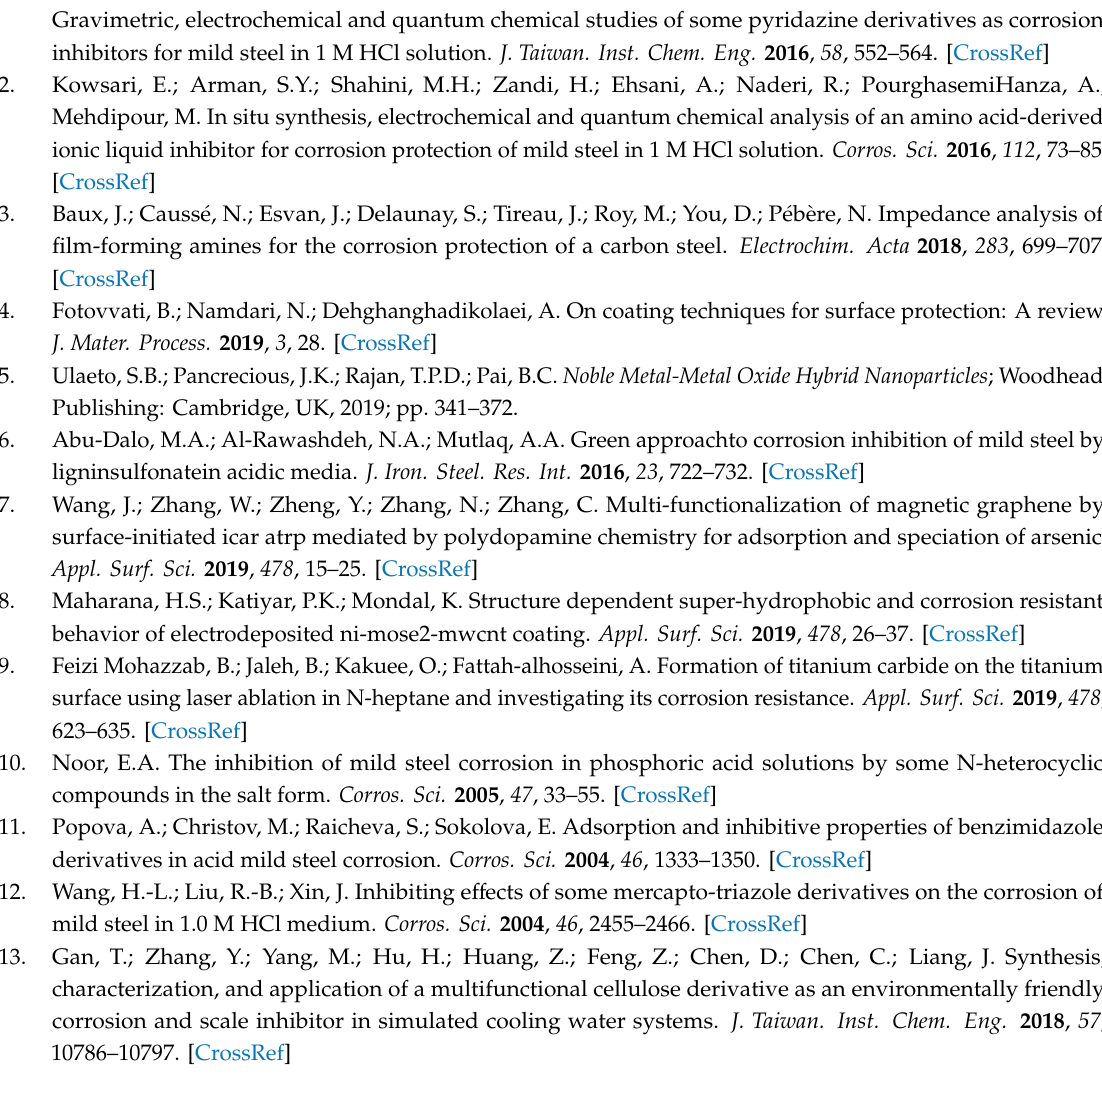
Figure S1. Schematic diagram of a lignin-DMC synthesis device, Figure S2. (a) The reaction mechanism and (b) The sketch of the lignin grafting reaction, Figure S3. FT-IR spectra of kraft lignin and lignin-DMC polymer, Figure S4. SEM micrographs of the Fe surface without 1.0 mol / L HCl (a), Fe surface after submersion in 1.0 mol / L HCl (b), 1.0 mol / L HCl with the addition of 75 mg / L lignin-DMC (c), and (d) Fe immersed in 1.0 mol / L HCl + 100 mg / L Lignin-DMC solutions, Table S1. Molecular weight and charge density of lignin, and lignin-DMC polymer, Table S2. Elemental analysis of lignin and lignin-DMC